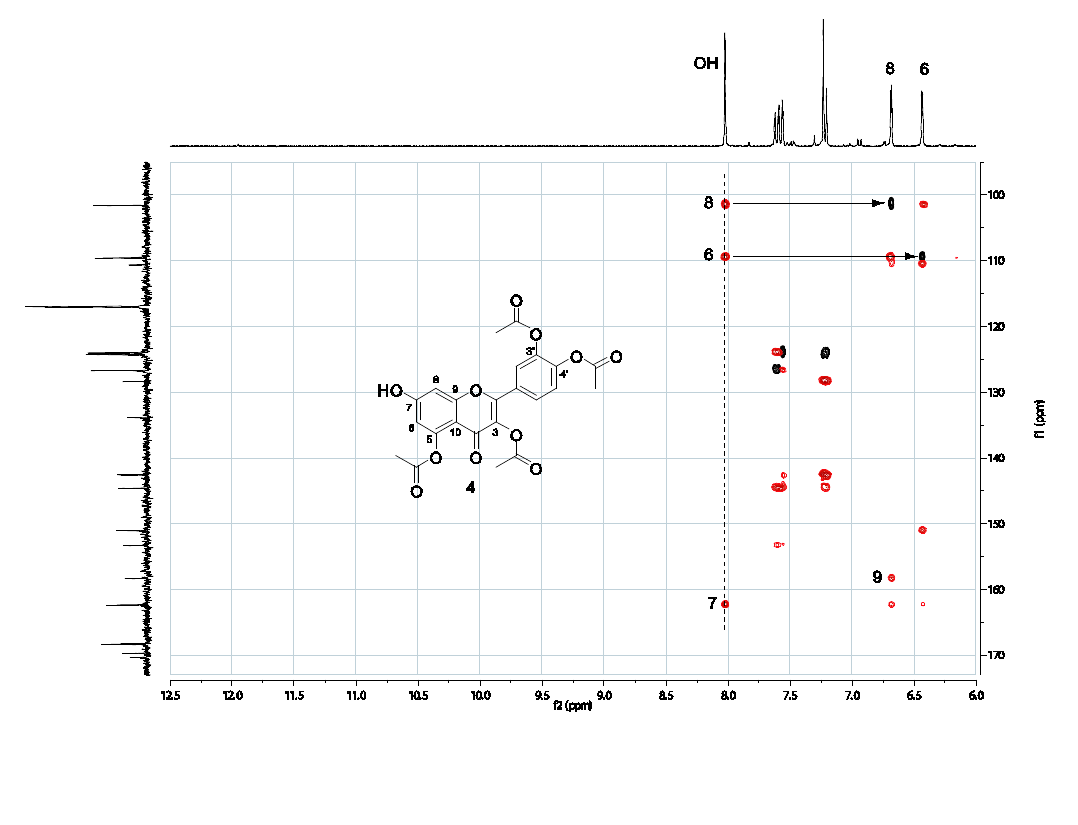
Figure 1. HSQC (black) and HMBC (red) spectra of 4